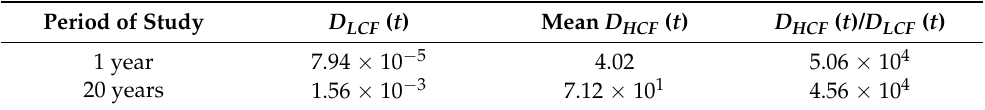
Table 1. Table showing the difference between LCF and HCF ( TI = 1%) damage estimations for different lengths of the study